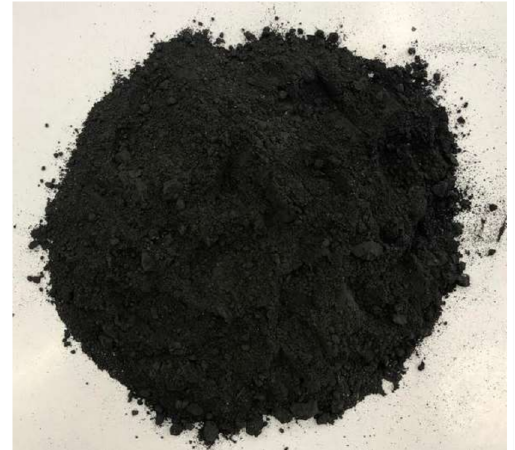
Figure 2. Post-pyrolysis char obtained after the separation of the solid